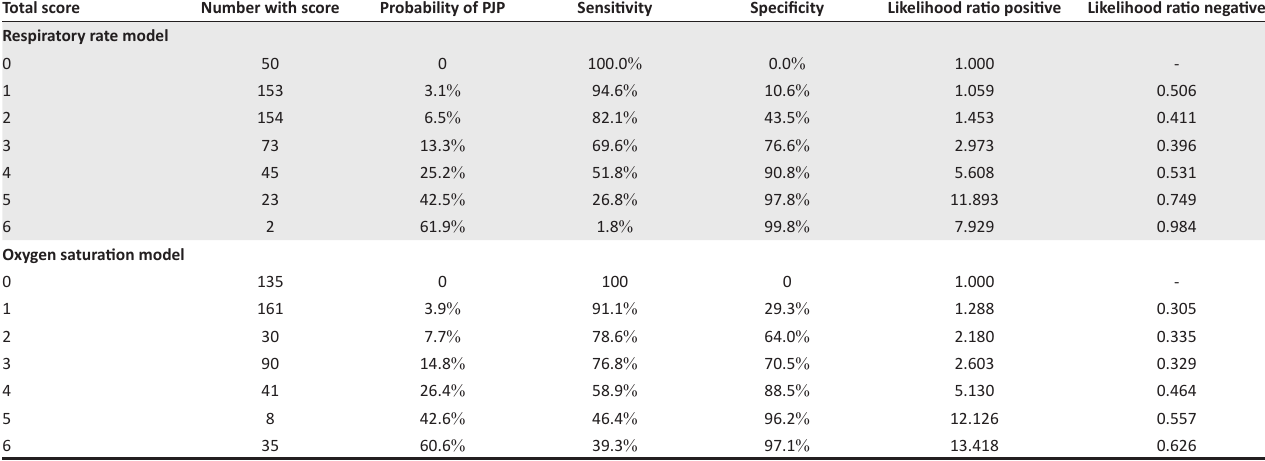
TABLE 5: Diagnostic accuracy assessment of the respiratory rate and oxygen saturation clinical prediction rules for the diagnosis of Pneumocystis jirovecii pneumonia among 500 seriously ill HIV-infected participants presenting with a cough of any duration and one or more World Health Organization danger signs. Total score Number with score Probability of PJP Sensitivity